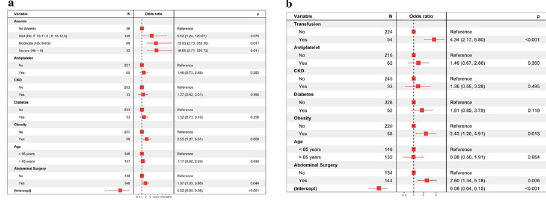
Fig. 1 Multivariate analysis analyzing the risk factors for the primary out‑ come (severe post‑operative complications and/or mortality) including anemia ( a ) or transfusion ( b ) CO‑26 Impact of blood products transfusions on the susceptibility to ICU‑acquired infections in septic